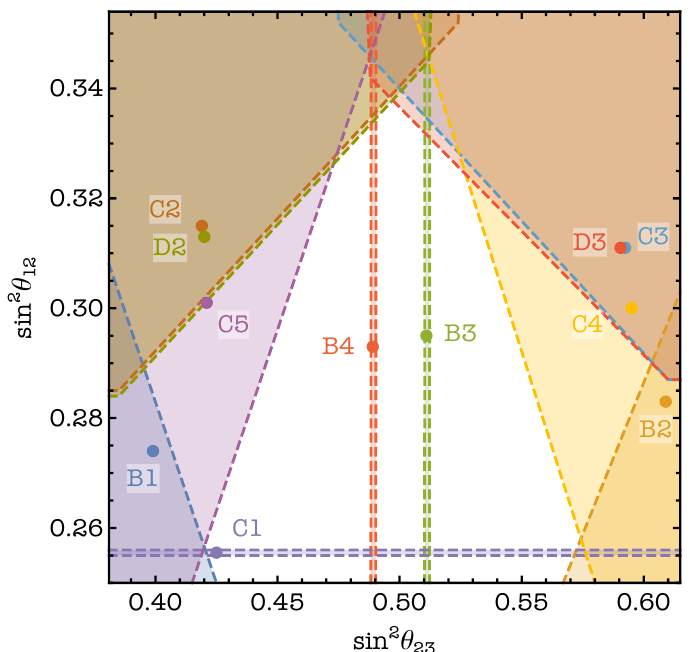
Figure 12 . Summary of the predicted allowed regions in the (sin 2 (cid:18) 23 ; sin 2 (cid:18) 12 ) plane and the corresponding best (cid:12)t points in cases B1{B4, C1{C5, D2 and D3 for the NO neutrino mass